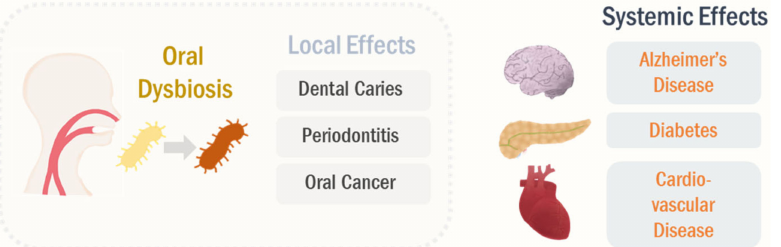
Figure 1. Local and systemic effects of oral microbiome. The oral dysbiosis can regulate the patho- logical processes in the oral cavity, such as dental caries, periodontitis, and OSCC. The altered oral microbiota profiles can further modulate systemic diseases, including Alzheimer’s disease, diabetes, and cardiovascular disease, beyond the local